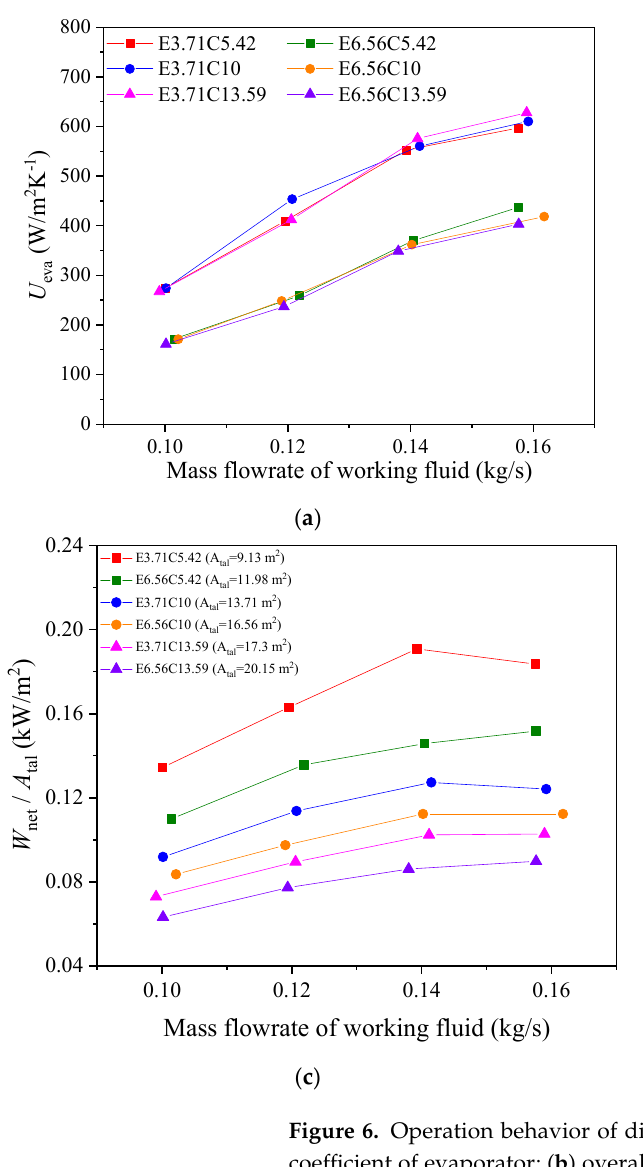
Figure 6. Operation behavior of different heat exchanger combinations: ( a ) overall heat transfer coefficient of evaporator; ( b ) overall heat transfer coefficient of condenser; and ( c ) heat exchanger area utilization of the ORC with different evaporator and condenser combinations [48]. Reproduced with permission from Zheng et al., Energy Conversion and Management; published by Elsevier, 2020.